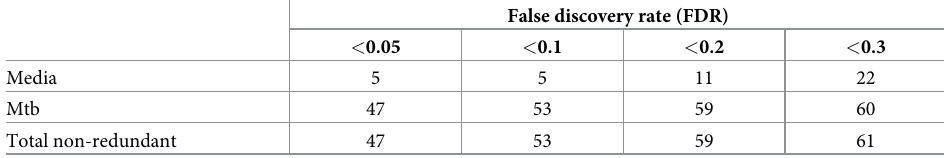
Table 2. Among genes with � 1 DET (FDR < 0.05), number of RSTR versus LTBI differentially expressed genes (DEGs) by condition and false discovery rate using